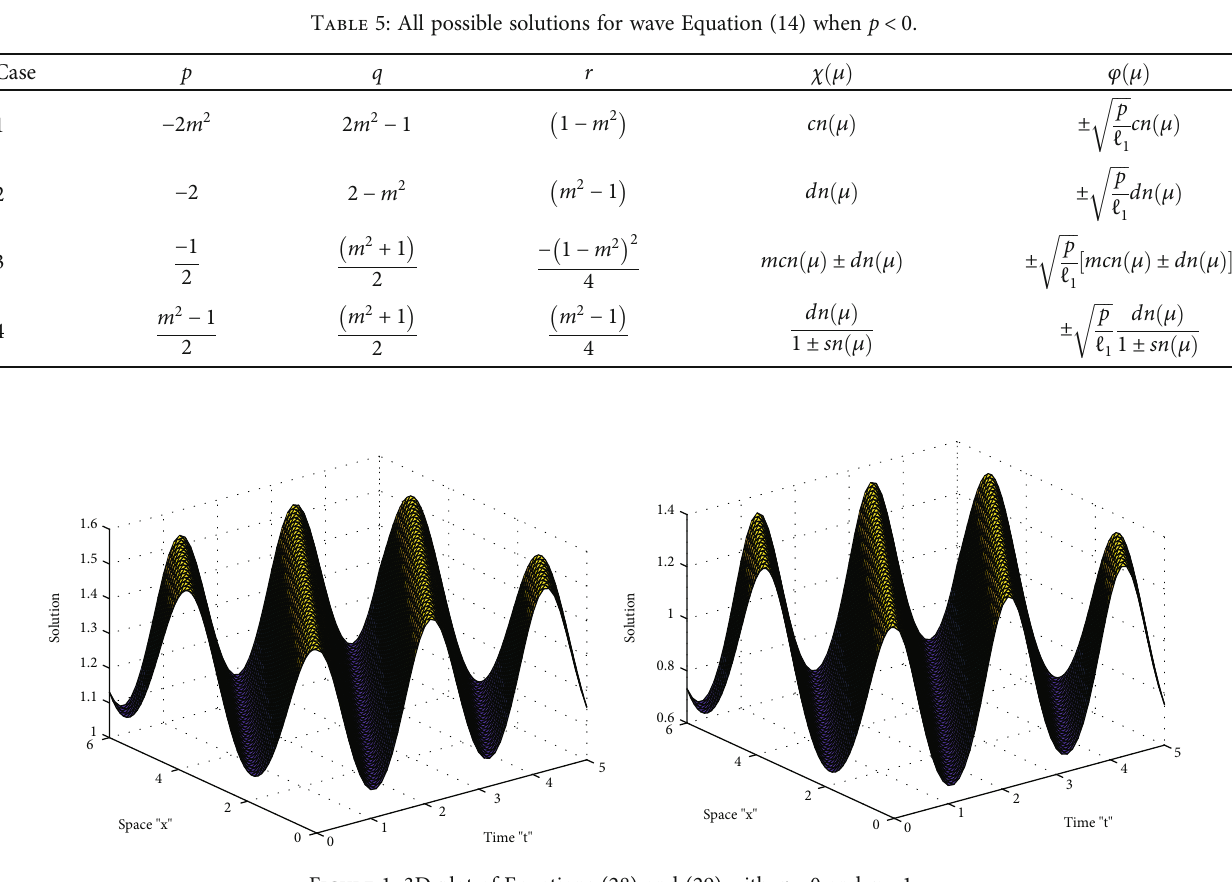
Figure 1: 3D plot of Equations (28) and (29) with σ = 0 and α = 1